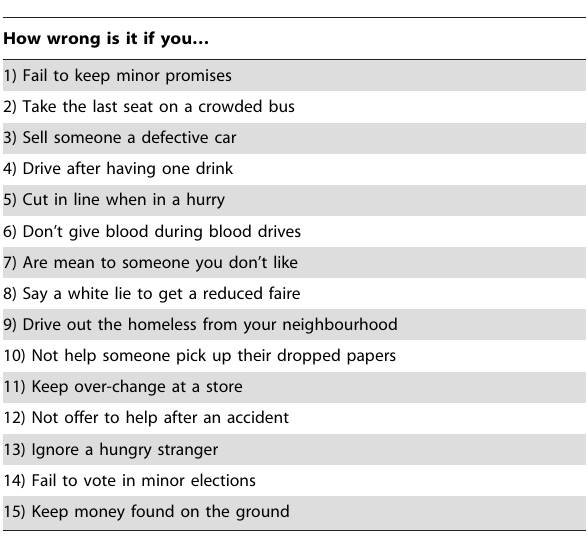
Table 1. Knowledge of explicit social and moral norms was evaluated using 15 items from the Moral Behaviour Scale [16], to which the subjects responded by choosing ‘‘not wrong’’, ‘‘mildly wrong’’, ‘‘moderately wrong’’ or ‘‘severely wrong’’, on a 4-point rating